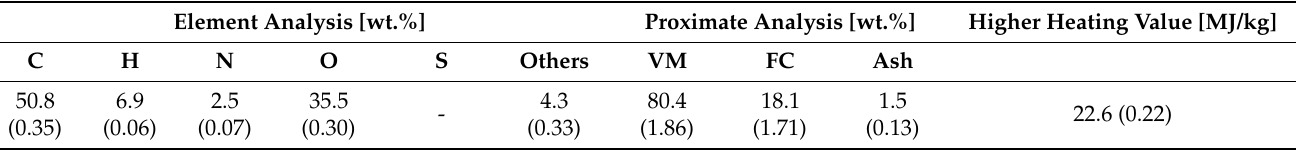
Table 1. Characteristics of dry spent coffee grounds used in this